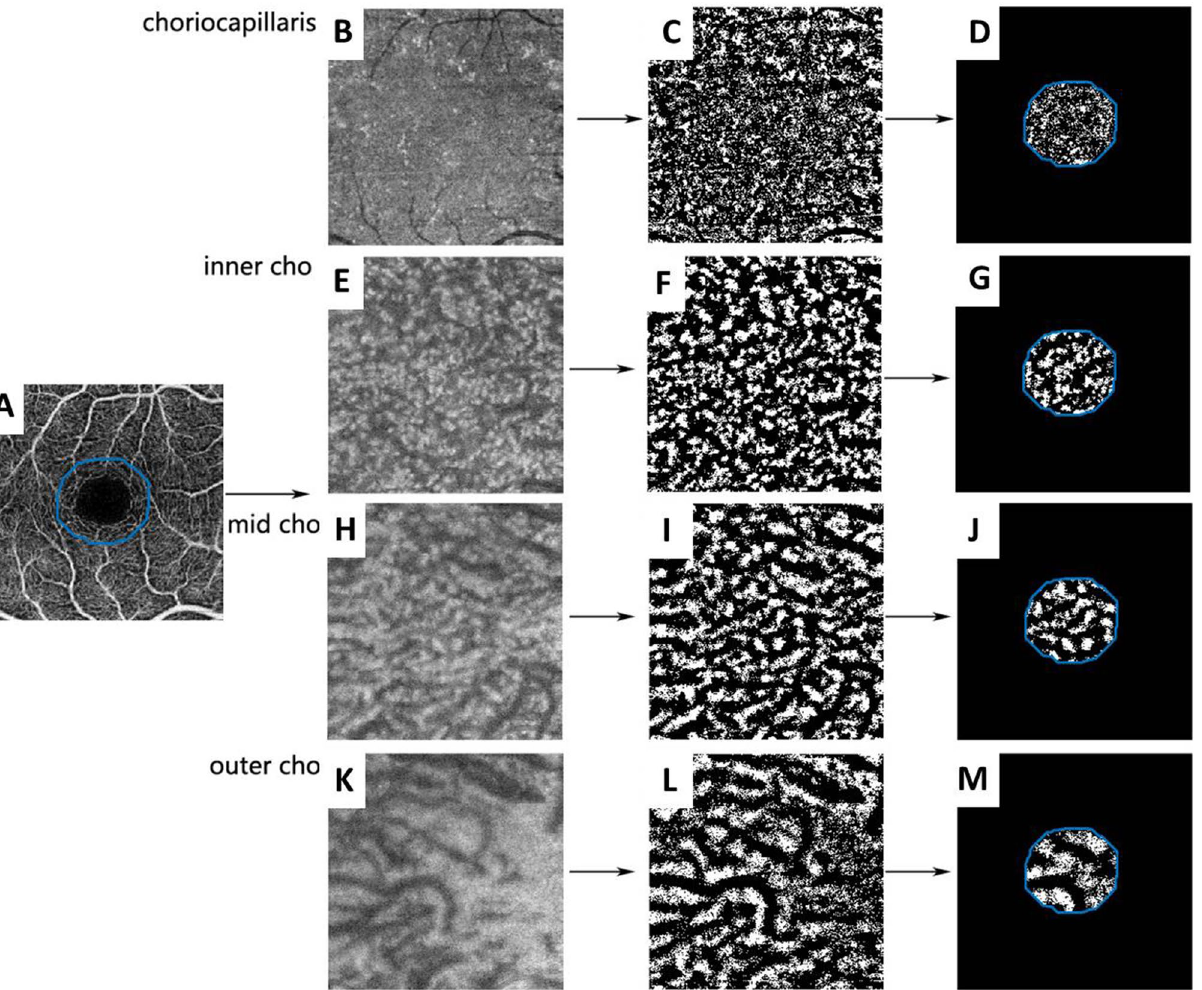
Figure 6. Representative exported and processed images. SS-OCTA and en face images were exported from the retinal superficial layer ( A ), choriocapillaris ( B ), inner choroid (inner cho, E ), mid-choroid (mid cho, H ), and outer choroid (outer cho, K ). These images were first aligned to the retinal superficial layer and then binarized in ImageJ ( C , F , I , L ). An area of approximately 1/3 of each image, centered on the fovea, was selected to calculate choroidal vessel density ( D , G , J , M ). SS-OCTA swept-source optical coherence segmentation distinguished the superficial retinal layers from 2.6 µm below the ILM to 15.6 µm below the IPL, while the offset for the deep retinal layers extended from 15.6 to 70.2 µm below the IPL. The CVDs of the choriocapillaris, inner choroid, mid-choroid, and outer choroid were calculated from bina- rized en face SS-OCTA images as described in a previous study, with some modifications 36 . First, we exported the retinal superficial slab and en face images of the default choriocapillaris slab (0–10.4 μm). We then measured the SFCT based on each image and exported the en face images of the inner, mid-, and outer choroid at one-quarter, one-half, and three-quarters of the SFCT. Second, the three superficial retinal slabs of each subject were aligned, and an area centered on the fovea of approximately 1/3 of each image was selected. Third, the choriocapillaris slab and inner, mid-, and outer choroid slabs were binarized and analyzed with MATLAB. The choroidal VD of each slab was calculated as the percentage area occupied by the choroidal vessels in the selected area (Fig. 6). Statistical analysis. The CT, SFCT, and HR values immediately after exercise and after 30 min of rest fol- lowing the exercise were normalized by subtracting the baseline (pre-exercise) values to obtain ΔCT, ΔSFCT, and ΔHR. ΔCT represented the mean CT of all selected areas. Because the ΔCT and ΔSFCT may be influenced by the baseline CT, we calculated the changing ratios of these parameters and obtained ΔCT% and ΔSFCT%. These two parameters were analyzed with independent t-tests. The MAP was determined by the following equation: MAP = [SBP + (2 × DBP)]/3 6 . All parameters were measured three times, and the mean values were calculated. Paired t-tests were used to analyze differences in RVD, CVD, ΔCT, ΔSFCT, ΔSBP, ΔDBP, and ΔHR between pre- exercise values and the post-exercise and post-rest values. Independent t-tests were used to analyze differences of all the measurement parameters and Chi-square test was used to analyze the difference of sex between myopic and emmetropic groups. The degrees of correlation between pairs of variables were expressed as Pearson’s cor-